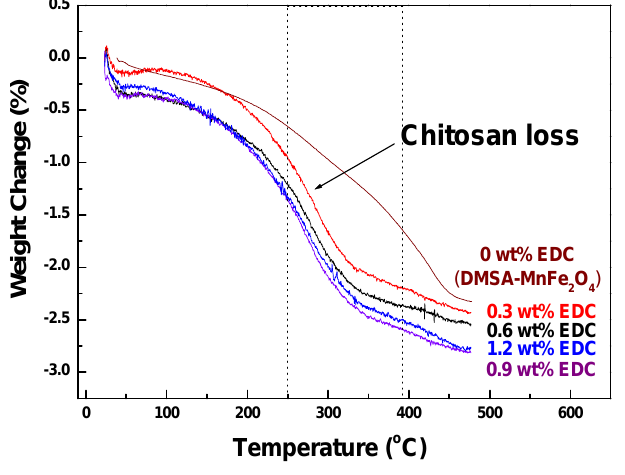
O MNPs synthesized using a range of EDC 2 4